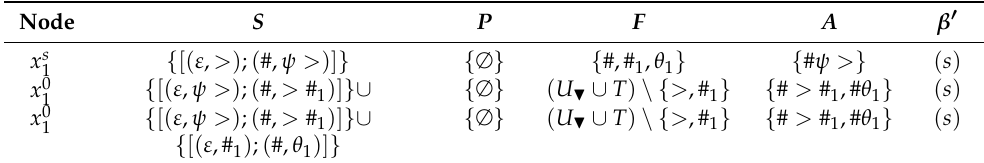
Table 1. Description of the initial nodes.